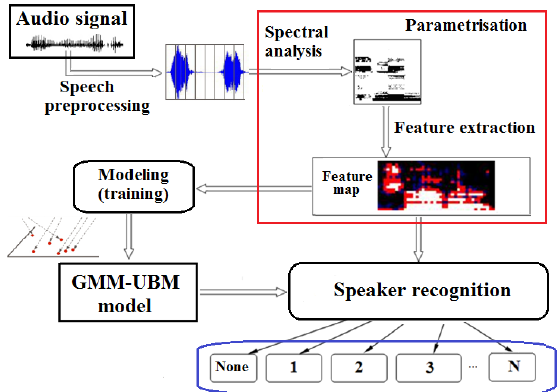
Figure 24. The UBM-GMM approach to speaker modelling and recognition.